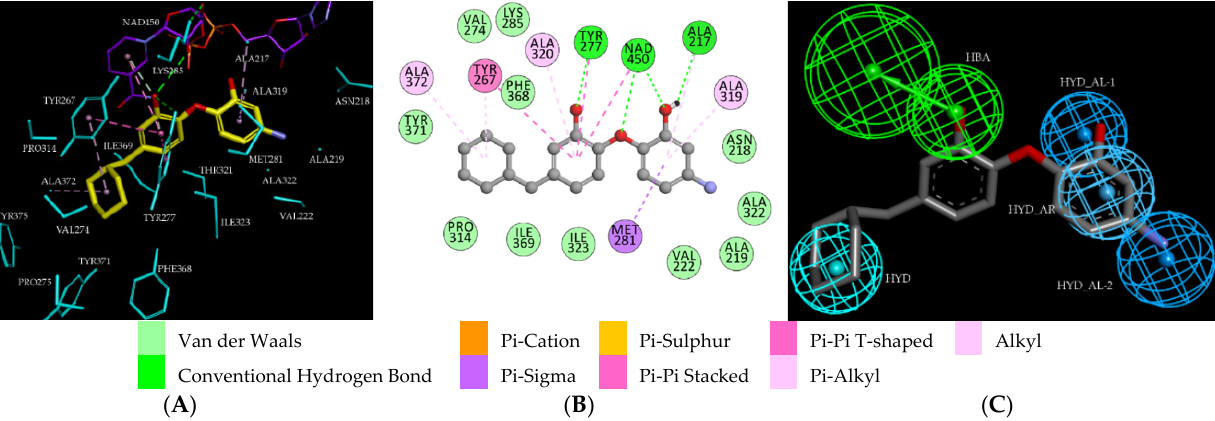
Figure 7. ( A ) Close ‐ up of one of the most active designed TCL analogues, TCL ‐ 33 ‐ 08 ‐ 05 ( IC (cid:2873)(cid:2868)(cid:2926)(cid:2928)(cid:2915) = 4.1 nM) at the active site of Pf ENR. The side chains of the interacting active site residues are coloured cyan, and carbon atoms of the ligand and the cofactor NAD (cid:2878) are colored yellow and purple, respectively. ( B ) 2D schematic interaction diagrams of the TCL ‐ 33 ‐ 08 ‐ 05 at the active site of Pf ENR. Atom colouring: C ‐ grey, N ‐ blue, O ‐ red. ( C ) Mapping of TCL ‐ 33 ‐ 08 ‐ 05 to the pharmacophore model for Pf ENR.